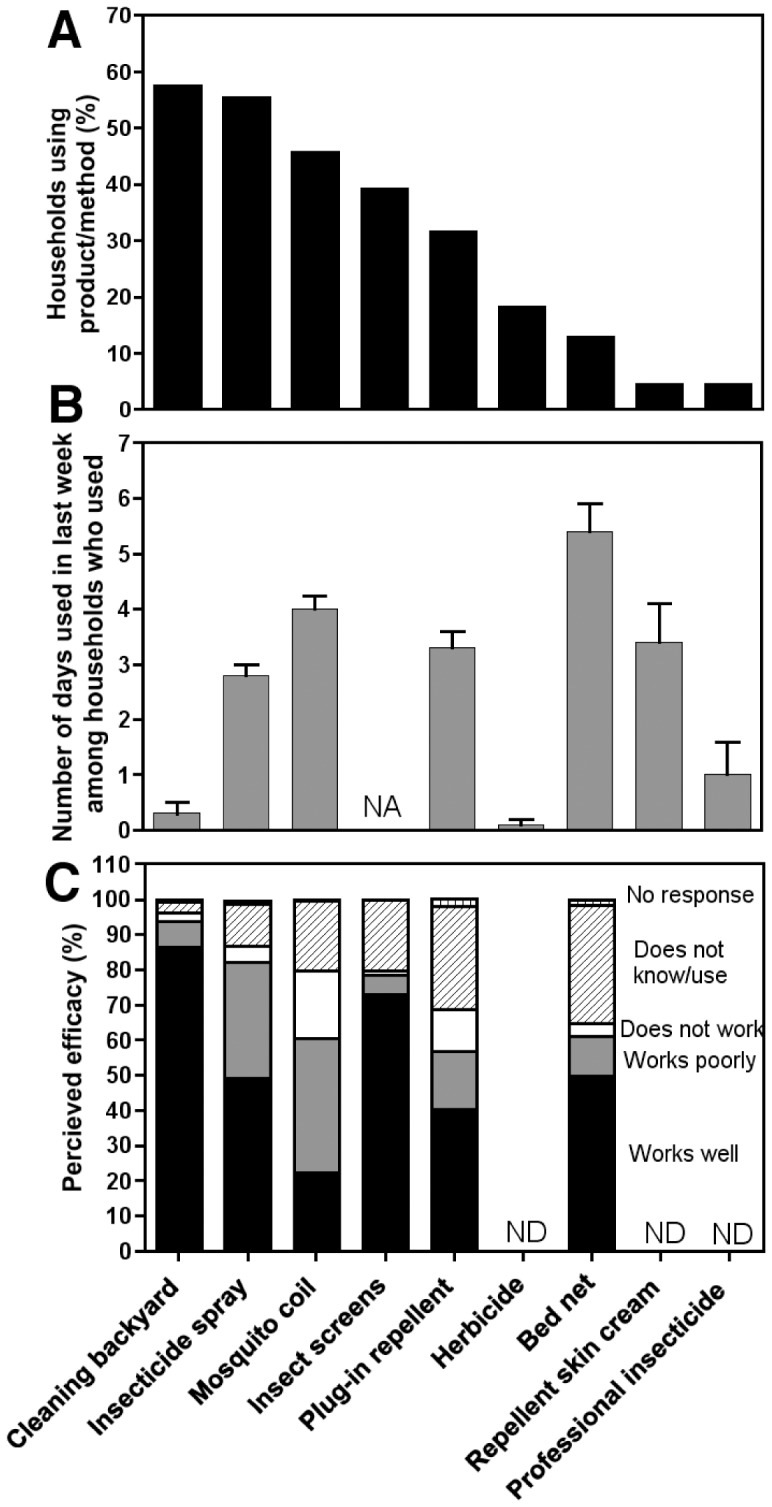
Use and perception of vector control measures.The percentage of households using each product/method (A), the number of days each product/method was used in the past week (B) and the perceived efficacy of each product/method (C) are shown. For perception, products/methods are classified as “works well”, “works poorly”, “does not work”, “does not know/use”, or “no response” as indicated. ND: not determined.